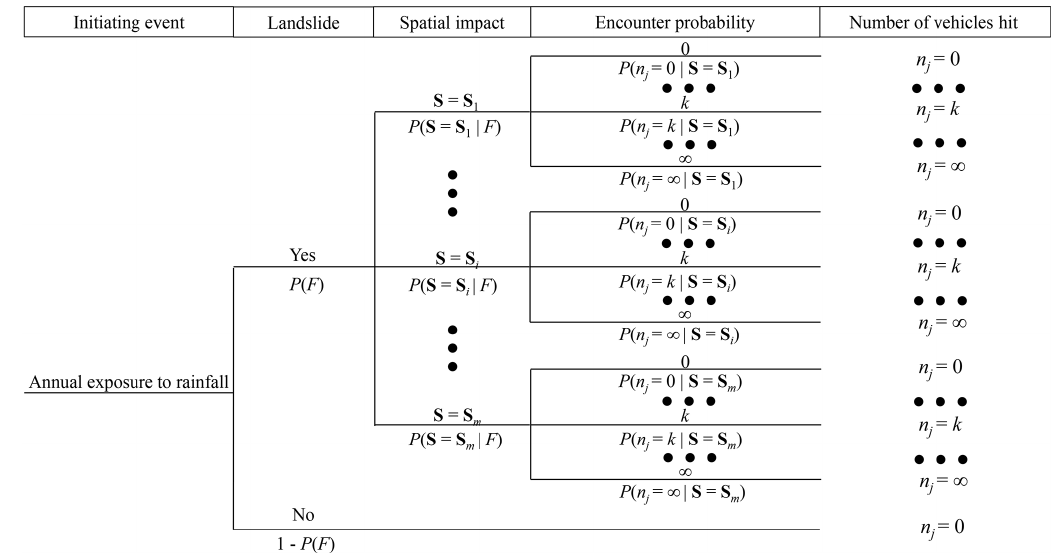
Figure 4. Event tree of the annual risk evaluation of type j vehicles being hit by a